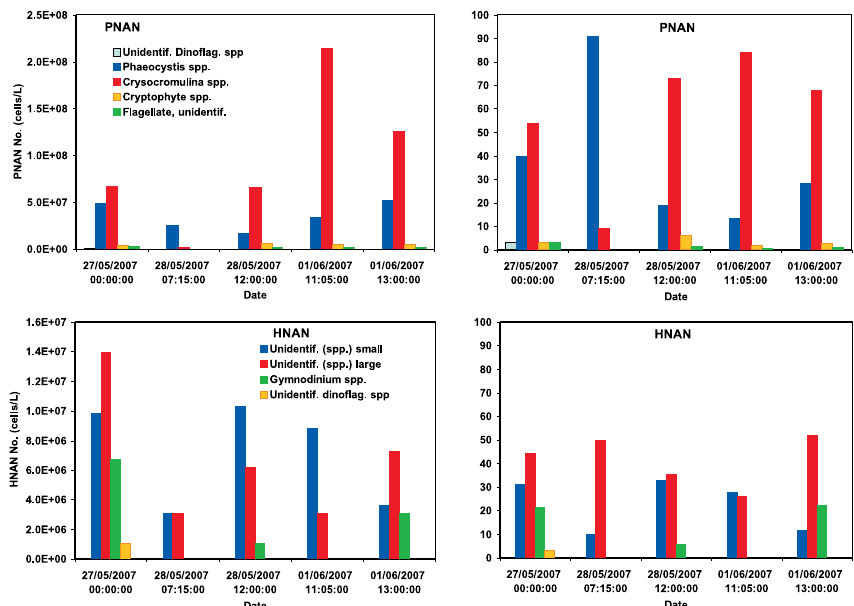
Fig. 3. Total and normalized cell counts for photosynthetic nanoplankton (PNAN) and heterotrophic nanoplankton (HNAN) populations in the oceanic seawater samples collected during the RHaMBLe cruise. Crysocromulina and Phaeocystis were identified as dominant species in the nanoplankton group.